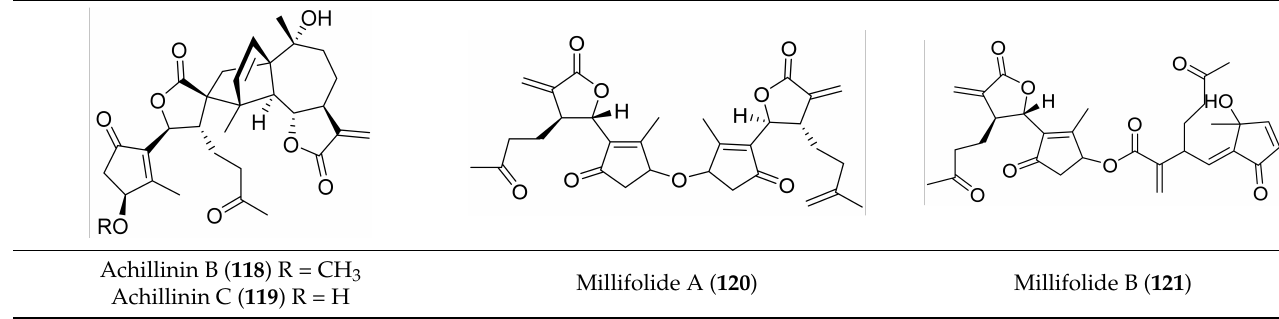
Table 10. Chemical structures of sesquiterpene lactone dimers from Achillea spp.